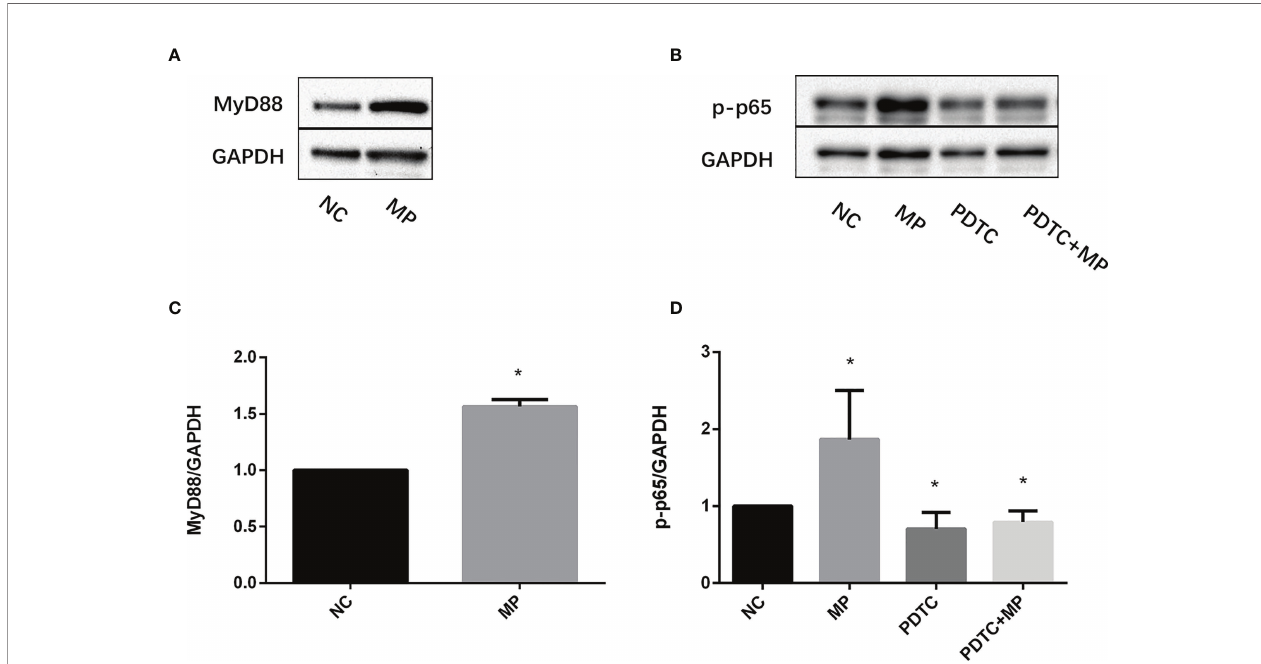
FIGURE 4 | Expression changes of MyD88 and p-p65 in A549 cells stimulated with M. pneumoniae . (A, B) A representative Western blot image. (C, D) Densitometry analysis of band intensity was performed. Quantitative densitometry of western blots was performed using Image J analysis. The expression was normalized to GADPH, GADPH was used as a loading control. Experiments were performed in biological triplicates. *P < 0.05 vs normal control group. P < 0.05 is statistically signi fi cant. NC, normal control; MP, Mycoplasma pneumoniae ; PDTC, Pyrrolidinedithiocarbamic acid (a NF- k B inhibitor).